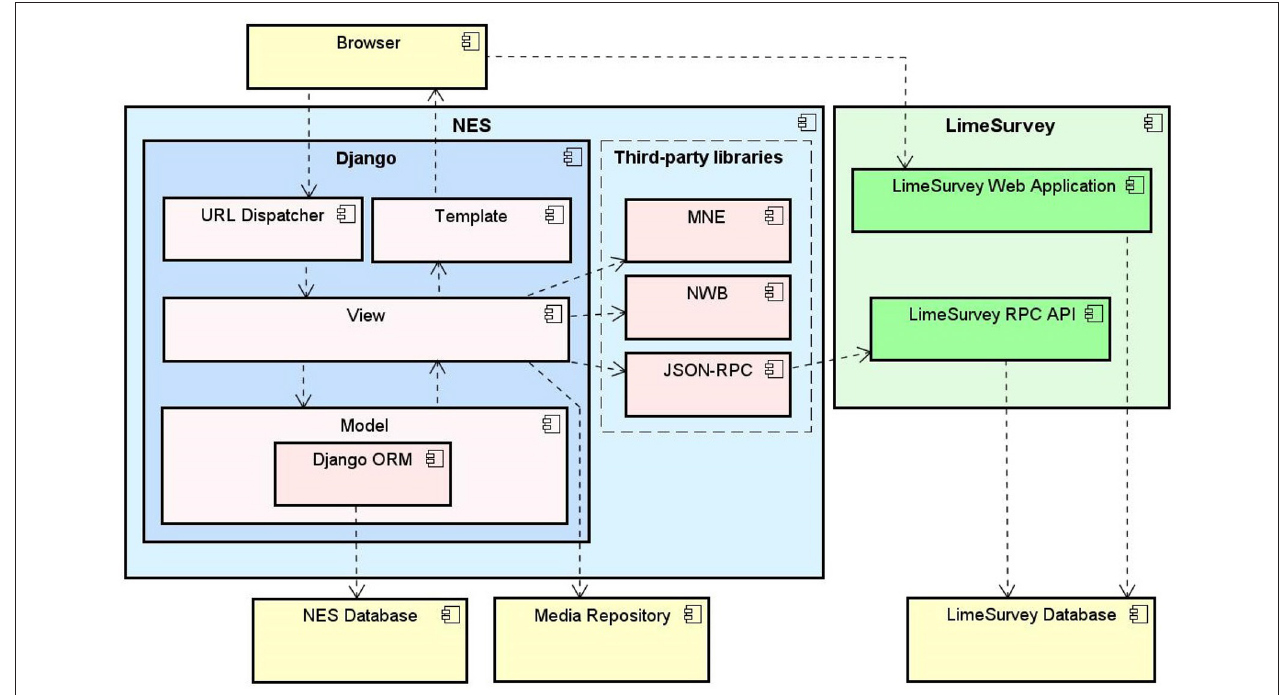
FIGURE 6 | NES software architecture, composed by the Django Web framework components and third-party libraries to convert data and provide interoperability with other tools.